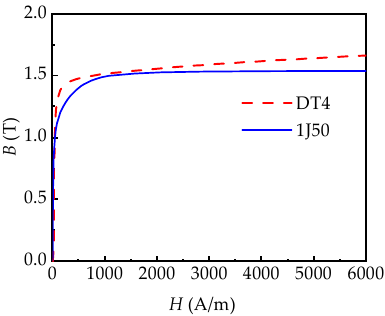
Figure 6. Magnetization curves of soft magnetic materials DT4 and 1J50.